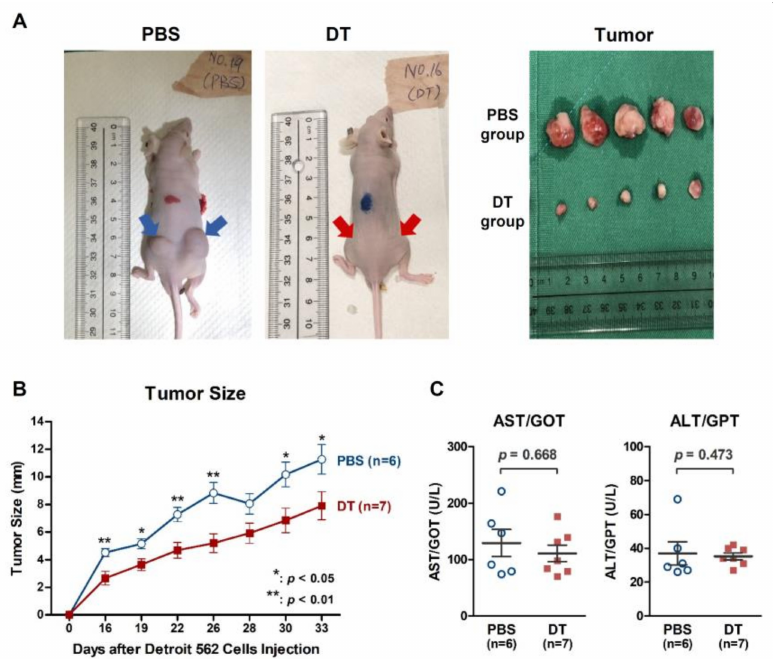
Figure 8. Antitumor effect of DT in the Detroit 562 HNSCCs xenograft model. ( A ) DT suppressed Detroit 562 tumor growth in xenografted mice. ( B ) The average tumor size in the DT group was significantly smaller than that in the control group. ( C ) Serum AST/GOT and ALT/GPT levels did not reveal a significant difference in liver function between the PBS and DT treatment groups. * indicates a statistically significant difference between the DT group and the PBS